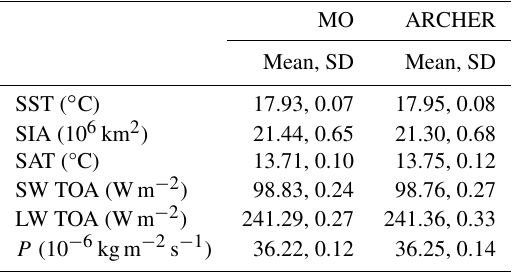
Table 2. The 200-year global mean and standard deviation for SST, SIA, SAT, SW TOA, LW TOA, and P .